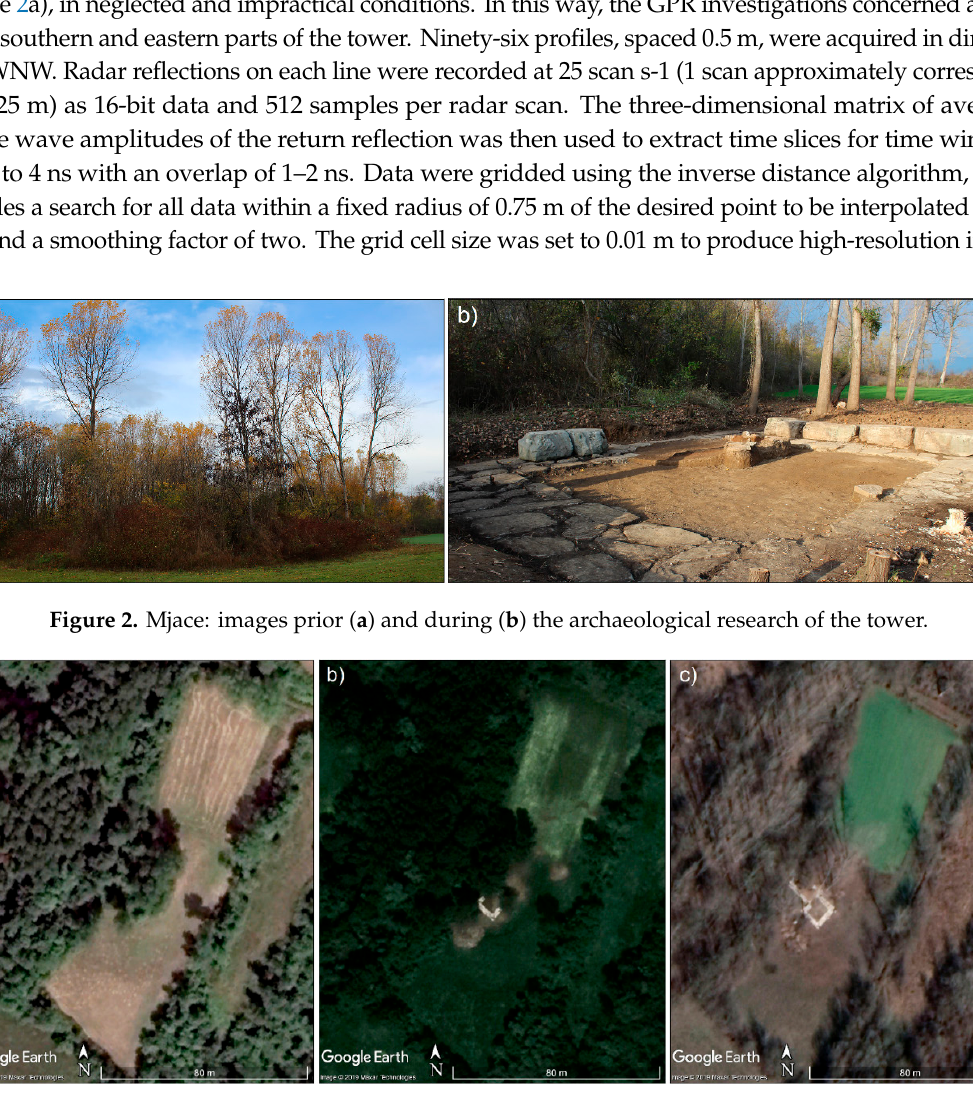
Figure 3. Mjace: Google Earth TM satellite images prior ( a ), during ( b ) and after ( c ) archaeological excavation.